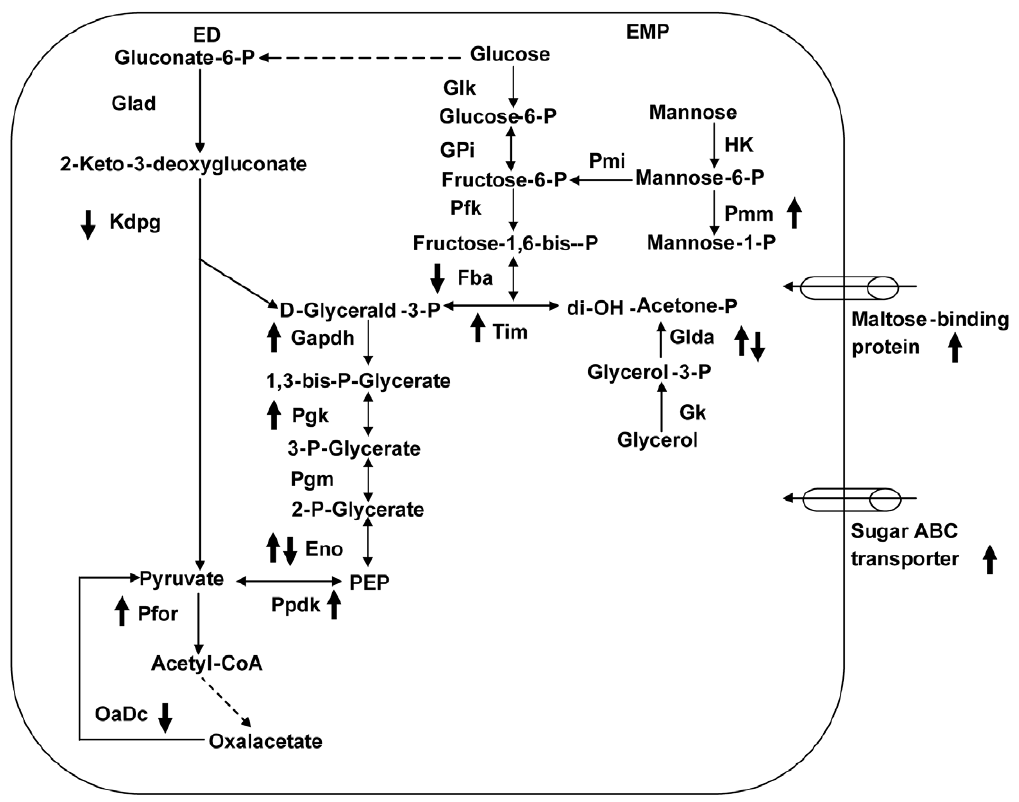
Figure 4. The possible network of central carbon metabolism in T.maritima . The symbols, ‘‘ q , Q , and Qq ,’’ indicate the protein abundances up-, down-, or bell-shaped-regulation response to temperature change. Abbreviations: ED , Entner–Doudoroff pathway; EMP , Embden–Meyerhof–Parnas pathway; XynC , family 10 xylanase XynC; Glad , gluconate dehydratase; Kdpg , 2-dehydro-3-deoxyphosphogluconate aldolase; Glk , glucokinase; Gpi , glucose-6-phosphate isomerase; Pfk , phosphofructokinase; Fba , fructose-1,6-bisphosphate aldolase; HK , hexokinase; Pmi , phosphomannoisomerase; Pmm , phosphomannomutase; Tim , triosephosphate isomerase; Glda , glycerol dehydrogenase; Gk , glycerol kinase; Gapdh , D-glyceraldehyde-3-phosphate dehydrogenase; Pgk , 3-phosphoglycerate kinase; Pgm , phosphoglycerate mutase; Eno , enolase; Ppdk , pyruvate,orthophosphate dikinase; Pfor , pyruvate synthase subunit porA; OaDc , oxaloacetate decarboxylase; CoA , coenzyme A; PEP , phosphoenolpyruvate.